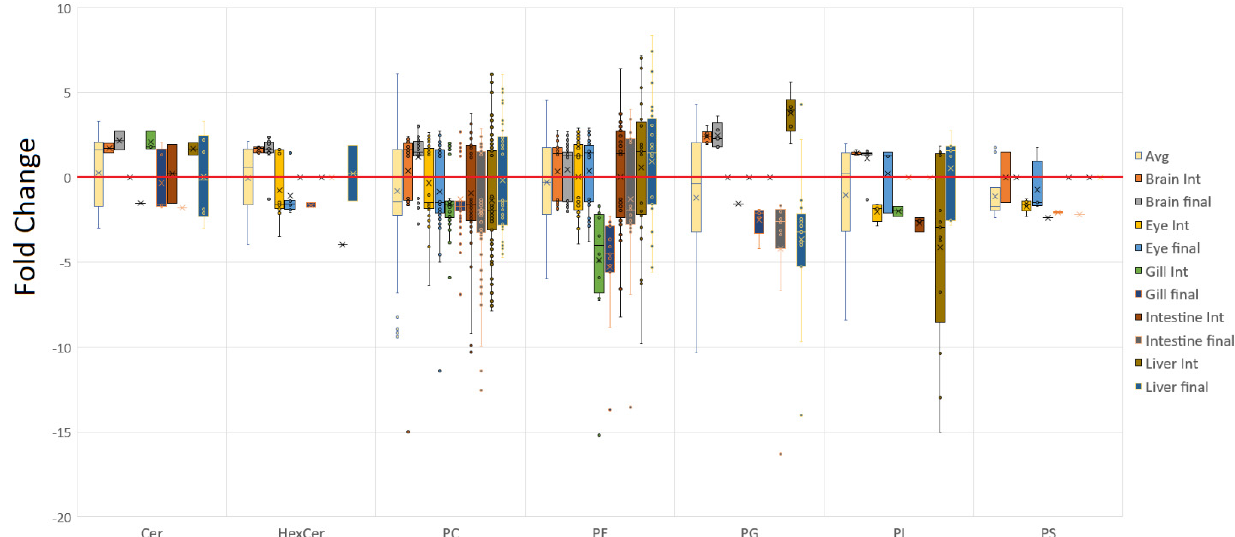
Figure 2. Phospholipid bias toward GM or control diets. Positive values indicate a general trend of being increased in fish fed the GM diet, whereas negative values indicate a general trend of being reduced by the GM diet, compared to fish fed the control diet. The brain in general was found to be positively affected by the GM diet, whereas the opposite was the case in the gill with the major lipid phospholipid class PC being primarily increased in fish fed the control diet.